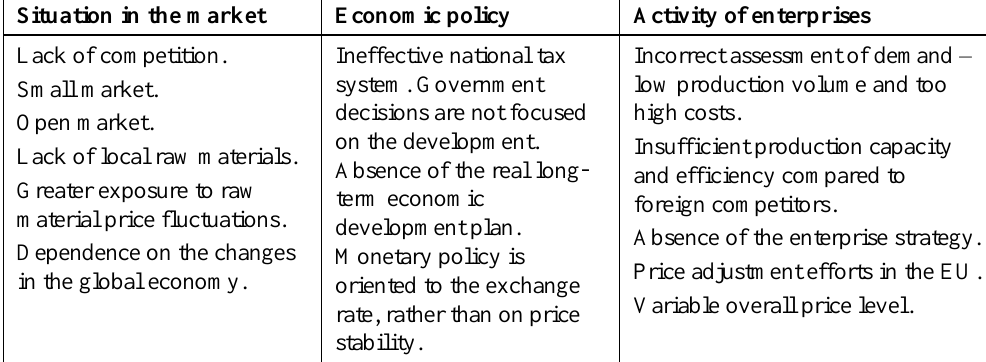
Table 5. The summary of price volatility promoting factors – expert mentioned problem evaluation (Bruksle, 2013, p.